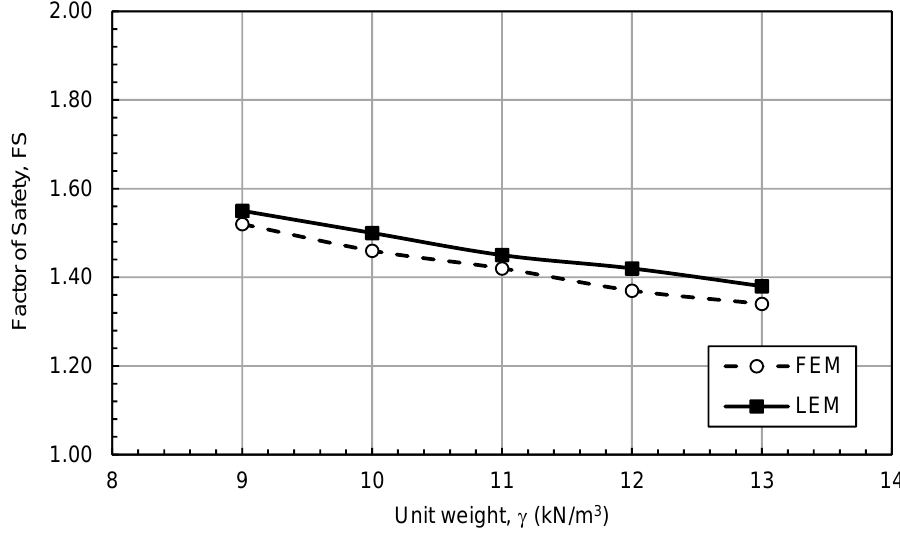
Figure 6. Variation of factor of safety, FS with unit weight, γ